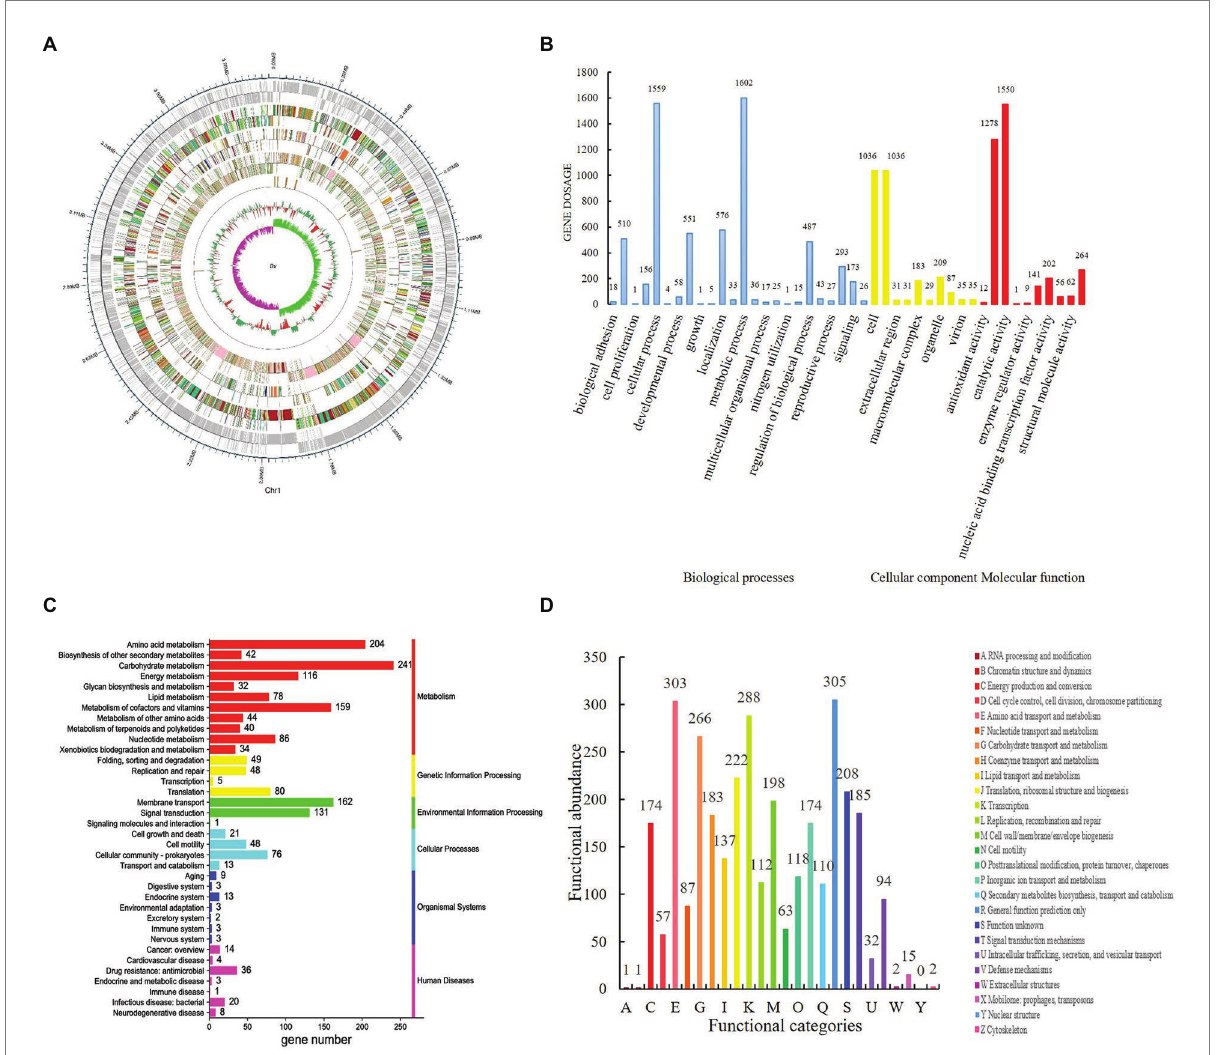
FIGURE 1 Genome-wide analysis of Bacillus velezensis SDTB038. (A) genome circular map of SDTB038 strain; (B) Gene Ontology (GO) sub-classification of SDTB038. Blue: biological process; Yellow: cellular components; Red: molecular functions; (C) Statistical chart of KEGG secondary function classification. Red: metabolism; Yellow: genetic information processing; Green: environmental information processing; Light blue: cellular process; Dark blue: organismal system; Light red: human disease. (D) Functional classification map of strain SDTB038 in COG.